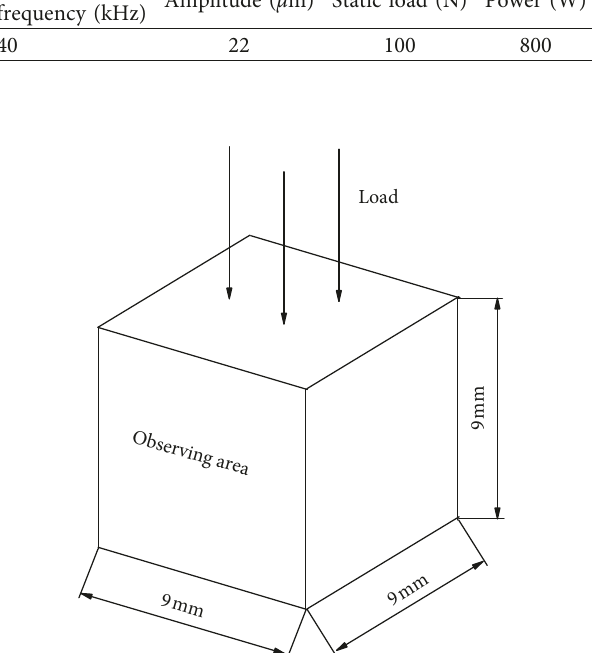
Figure 6: Schematic diagram of sample loading and